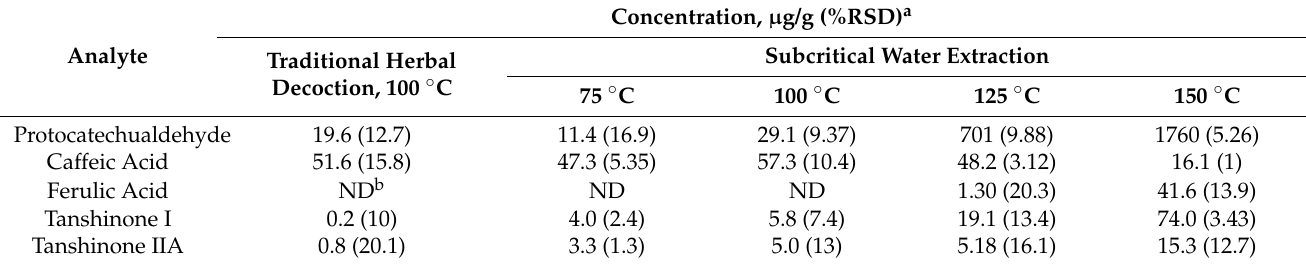
Table 1. Comparison of active pharmaceutical ingredient (API) concentrations found in Salvia miltiorrhiza obtained by traditional herbal decoction and subcritical water extraction.